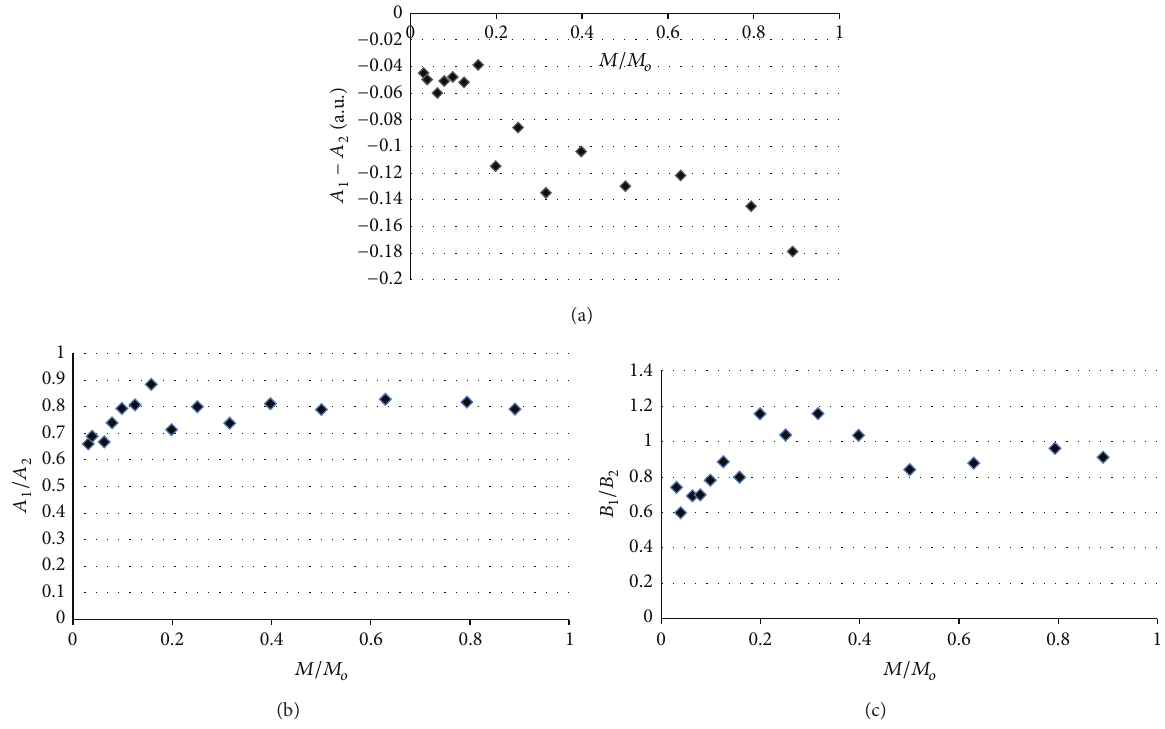
Figure 8: The effect of microwave power on the line shape parameters: (a) 𝐴 1 −𝐴 2 , (b) 𝐴 1 /𝐴 2 , and (c) 𝐵 1 /𝐵 2 , for the EPR spectra of bismuth subgallate thermally sterilized at 170 ∘ C (60 minutes). 𝑀 —microwave power used during the measurement of the EPR spectra, 𝑀 𝑜 —total microwave power produced by klystron (70